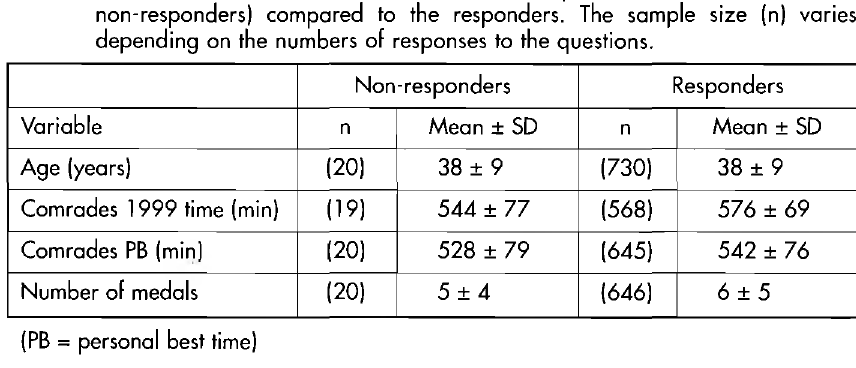
Table 5: Data of the runners who declined to fill in the questionnaire (36% of the total non-responders) compared to the responders. The sample size (n) varies depending on the numbers of responses to the